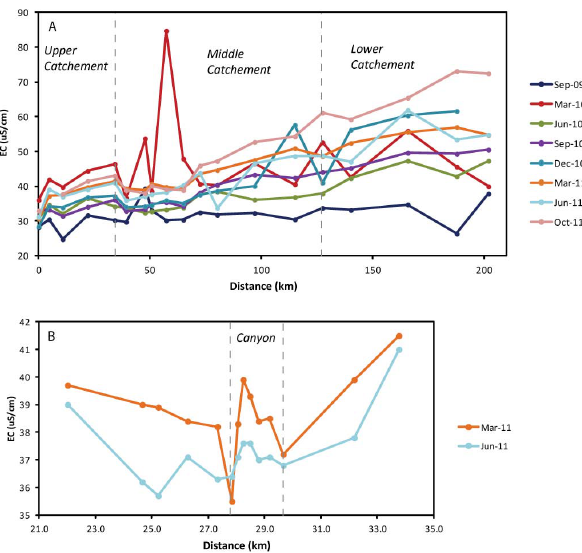
Fig. 4. (A) EC values along the course of the river (Table 1). EC val- ues gradually increase downstream. (B) EC values along the Bright– Porepunkah reach in March and June 2011. Distinct EC peaks at 28.5km, followed by a gradual increase in EC values in both sam- pling